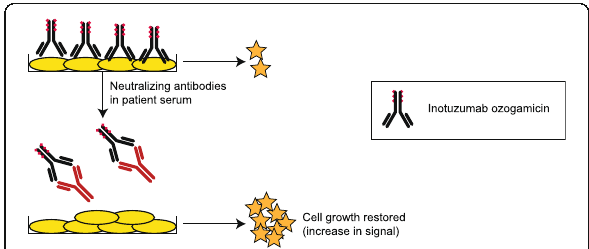
Fig. 3 Detection of anti-drug neutralizing antibodies during ALL studies. In the presence of inotuzumab ozogamicin, apoptosis of RS4;11 cells results in the reduction of signal. ALL=acute lymphoblastic